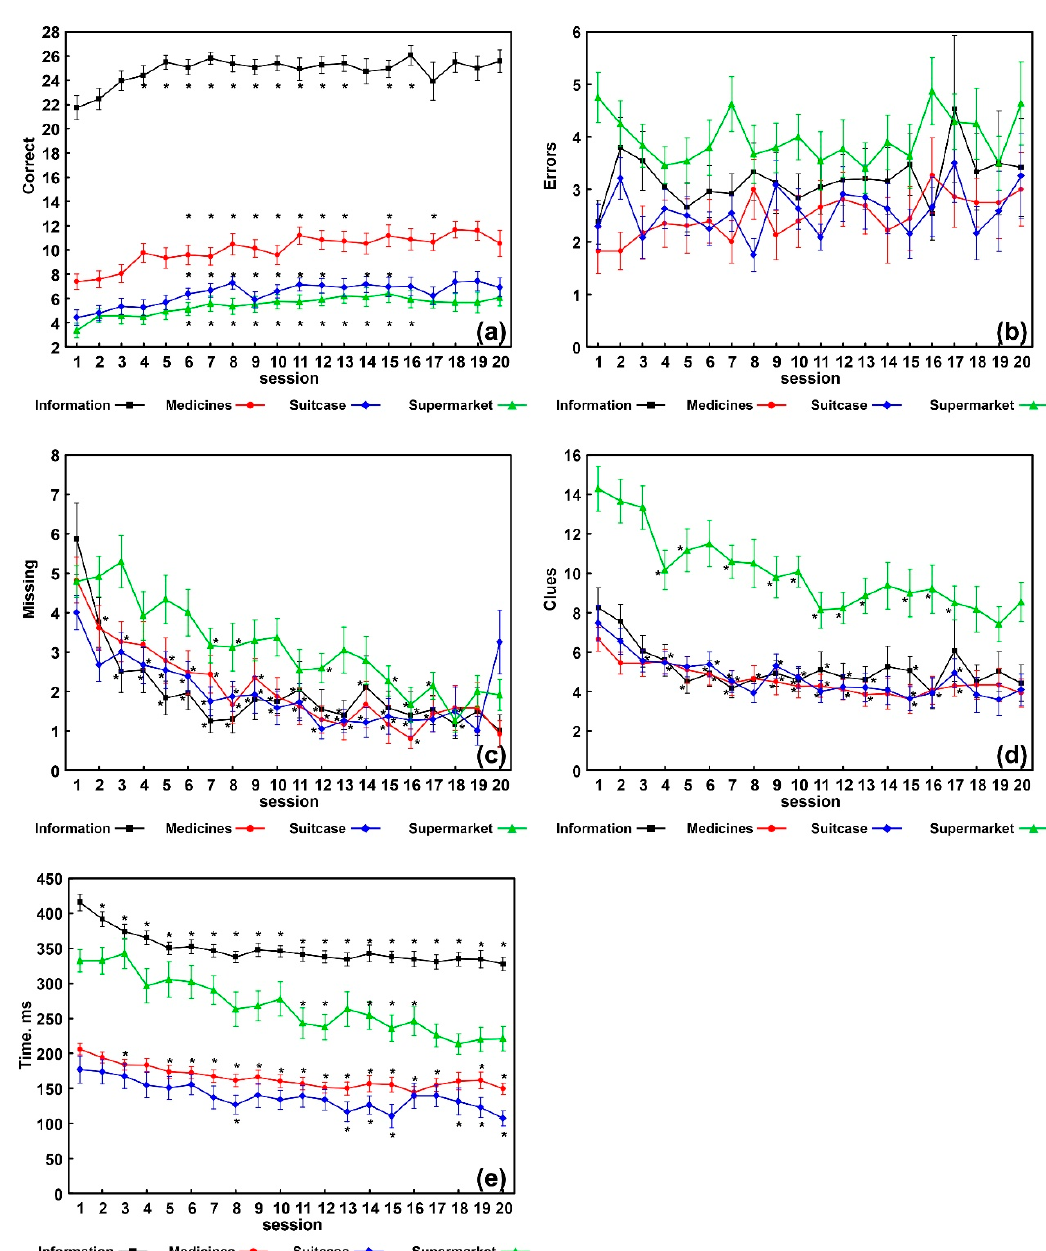
Figure 1. Results obtained in each of the 20 sessions in each task; data are shown as mean (squares, circles, diamonds, and triangles) and standard errors (whiskers), asterisks indicate a statistically significant difference (Wilcoxon rank test, Bonferroni-corrected p < 0.05 vs. the value obtained for session 1. ( a ) Number of correct responses; ( b ) number of errors; ( c ) number of missing responses; ( d ) number of clues provided; ( e ) average execution time during the